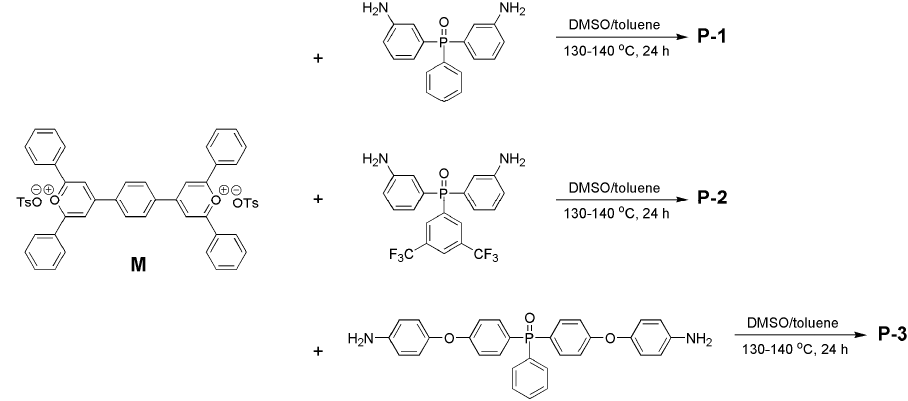
Figure 3. 1 H and 13 C NMR spectra of ionic polymer P-1 in d 6 -DMSO taken at room temperature. Figure 4. 1 H and 13 C NMR spectra of ionic polymer P-2 in d6- DMSO taken at room